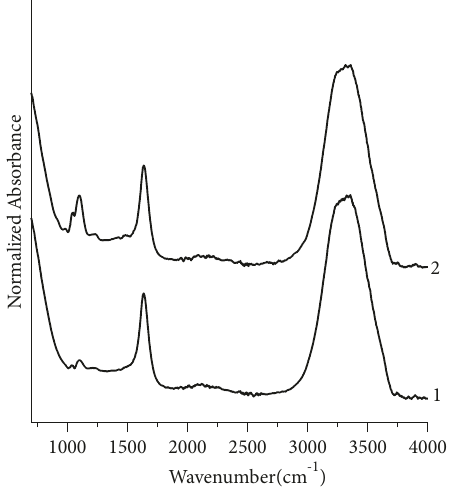
Figure 7: Normalized FTIR absorption spectra for black fountain pen inks. 1, 2, 3, 4, 5, and 6 represent samples no. BK1, BK2, BK3, BK4, BK5, and BK6, respectively.